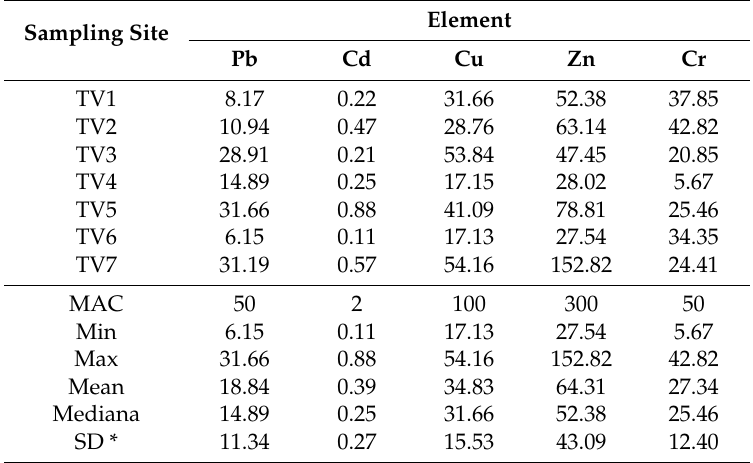
Table 5. Total contents and descriptive statistics of elements in Tivat (TV) urban parks soil samples for this study (mg ¨ kg ´ 1